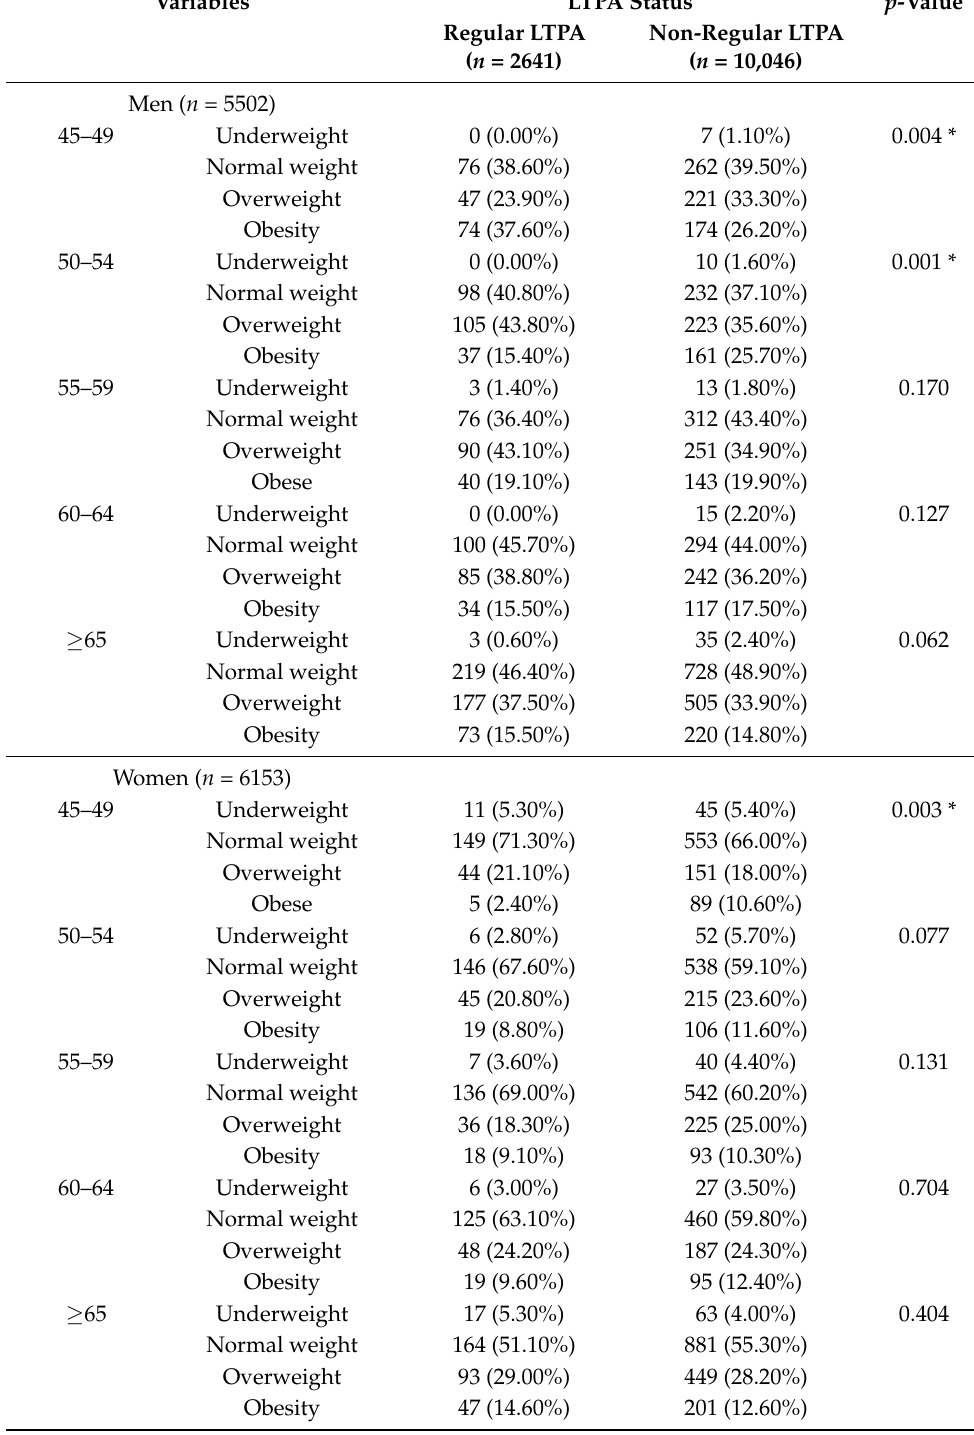
Table 3. Comparison between prevalence of overweight/obesity and LTPA status among middle- aged and older adults in